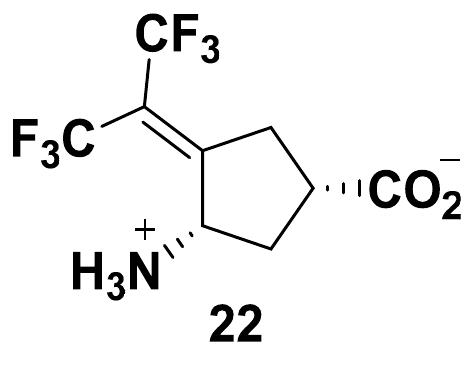
Figure 6. The structure of compound 22.